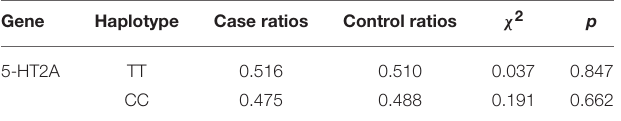
TABLE 4 | Haplotype-based association analysis results.